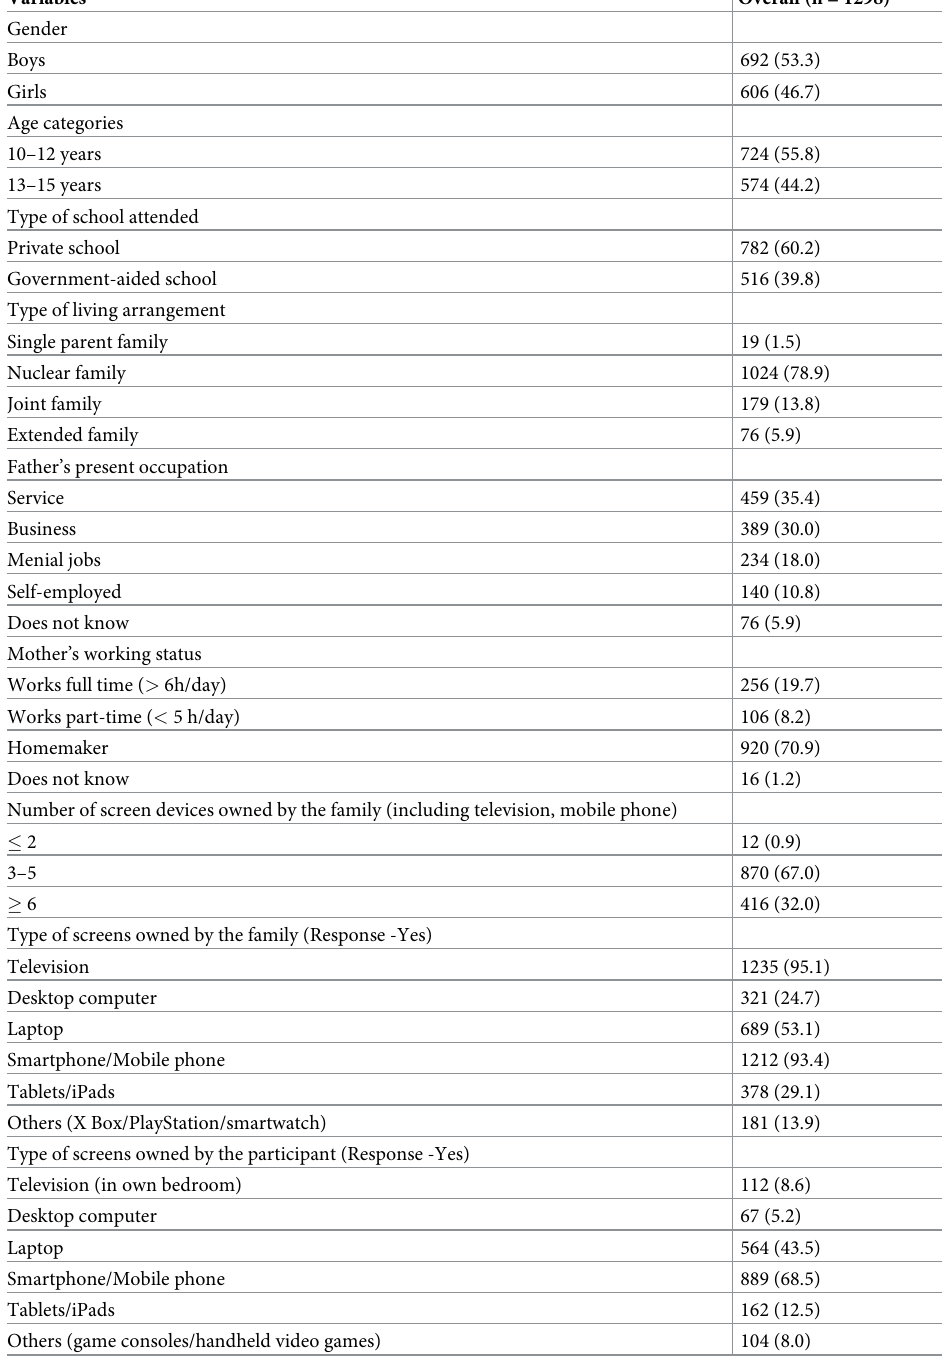
Table 1. Demographic characteristics of 10–15 years old adolescents in the study